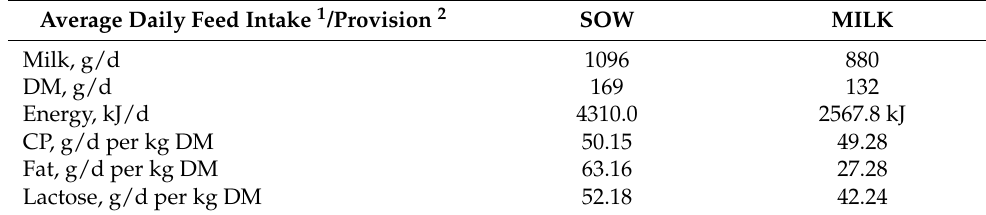
Table 2. Average daily milk and nutrient intake of sow (SOW)-reared piglets based on estimates from Theil et al., 2007 [12], and average daily milk and nutrient supplement of artificially (MILK) reared piglets. Average Daily Feed Intake 1 /Provision 2 SOW Milk, g/d